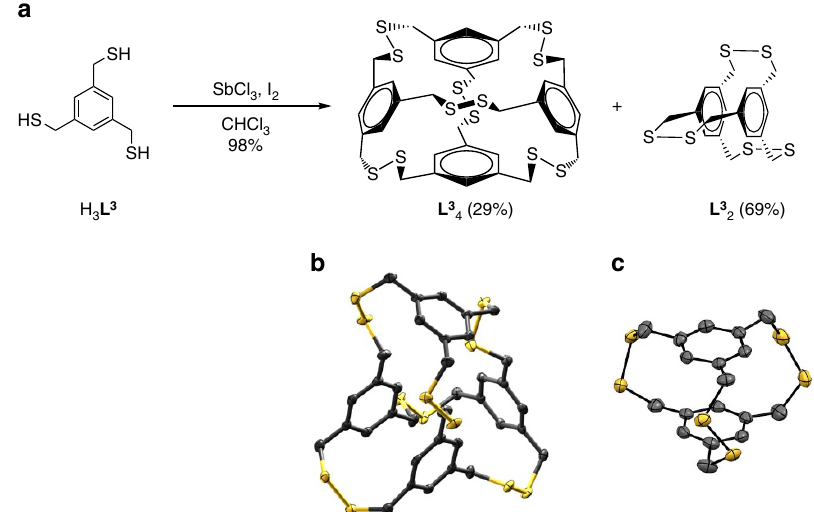
Figure 2 | Synthesis and crystal structure of disulfide dimer and tetrahedron. ( a ) Pnictogen-activated iodine oxidation of H 3 L 3 cleanly forms disulfide macrobicycle L 3 2 (dimer, 69%) and tetrahedron L 3 4 (tetramer, 29%) in combined 98% isolated yield at B 2mM concentration (1 equiv H 3 L 3 , 2.5 equiv SbCl 3 ; 3 equiv I 2 ). Single-crystal X-ray structure representations of tetrahedron L 3 4 ( b ) (thermal ellipsoids at 50%) and dimer L 3 2 ( c ) (thermal ellipsoids at 30%). Hydrogen atoms and solvents of crystallization have been omitted for